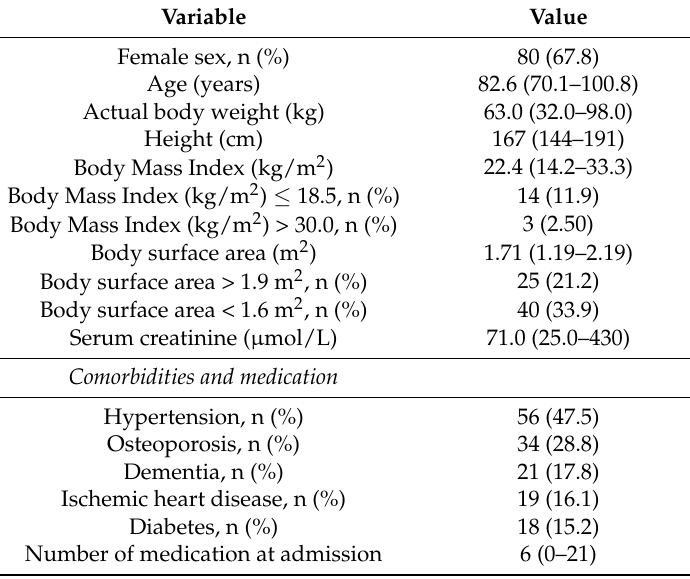
Table 1. Demographic data (n = 118), median values with range.